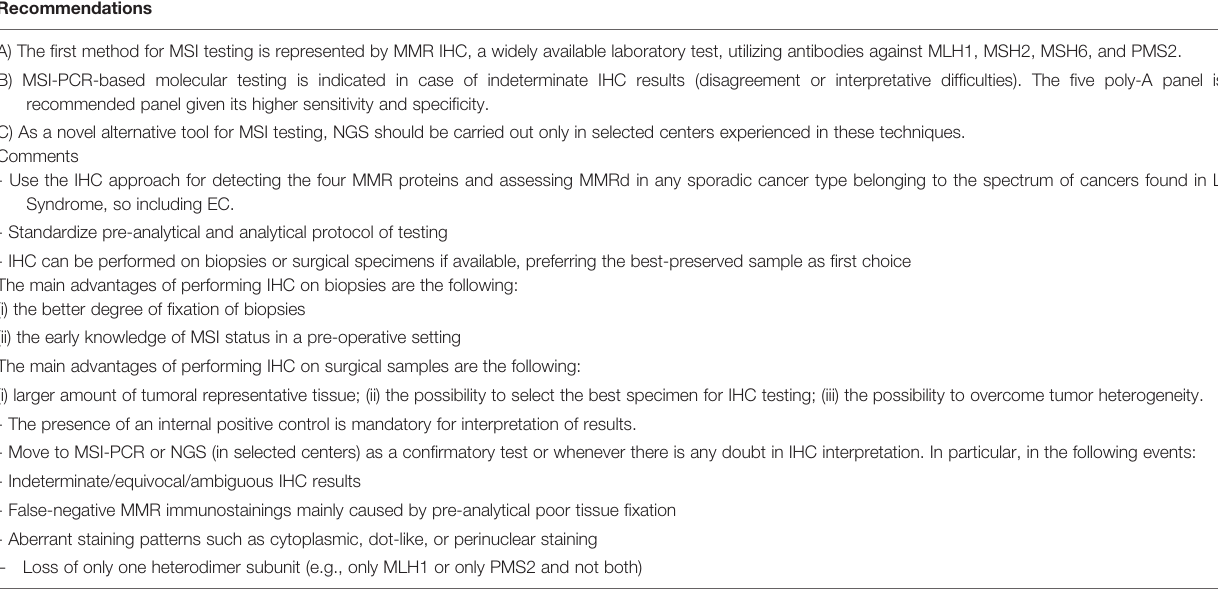
TABLE 2 | MSI: recommendations and comments from the working group.